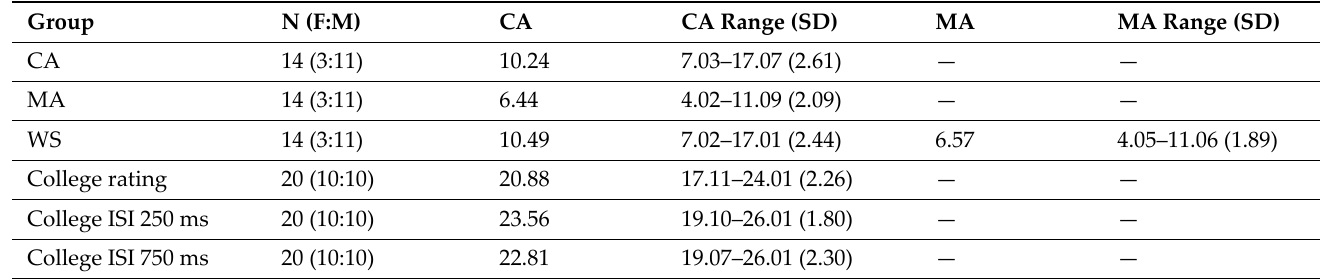
Table 1. Background information on